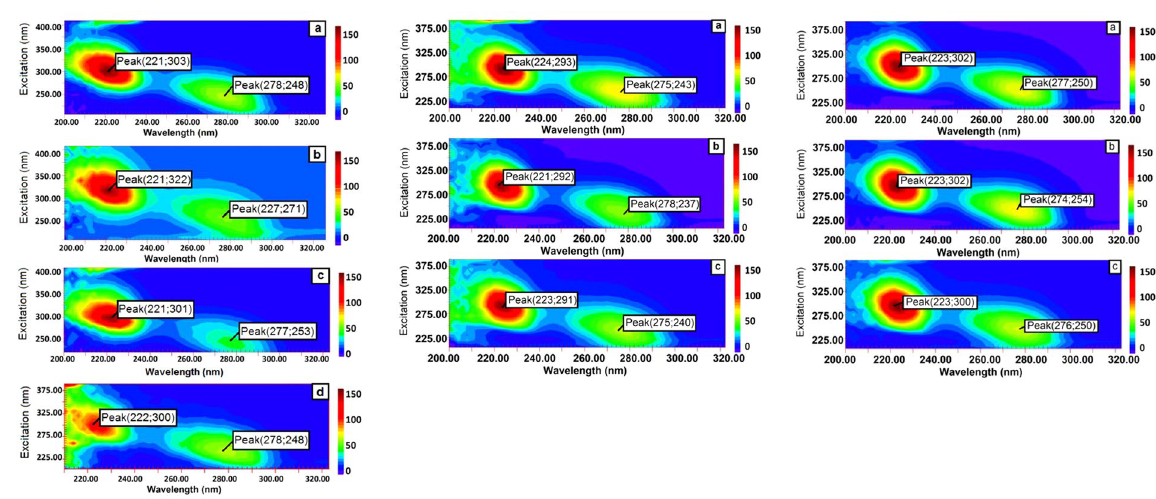
Figure 5. Synchronous fluorescence spectra of САВ, AcP, HRP native enzyme ( a ), denatured enzyme ( b ) renatured free enzyme ( c ) and renatured-complexed CAB ( d ).